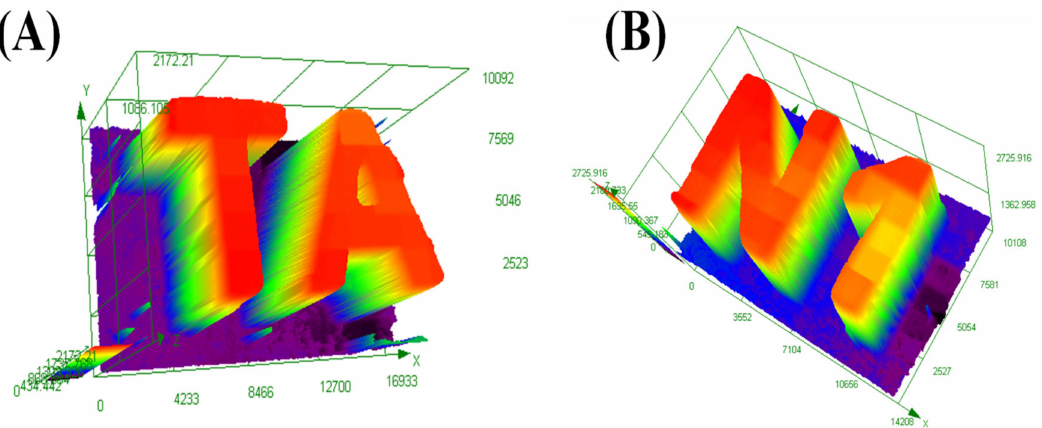
Figure 5. Free radical polymerization experiments by DLW using a laser diode @405 nm for 3D patterns character- ized by numerical optical microscopy: ( A ) Napht-1/Iod/TMA (0.025%/0.5%/0.36% w/w/w ); ( B ) Napht-2/Iod/TMA (0.025%/0.5%/0.42% w/w/w